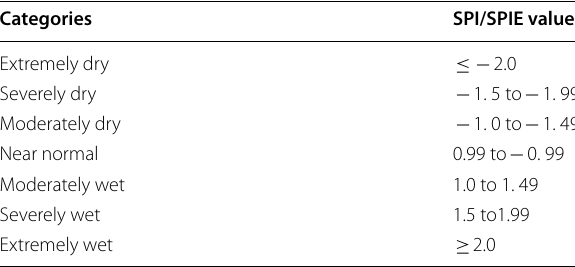
Table 2 Classification of the severity of drought events on the calculation of SPI/SPIE (McKee et al.